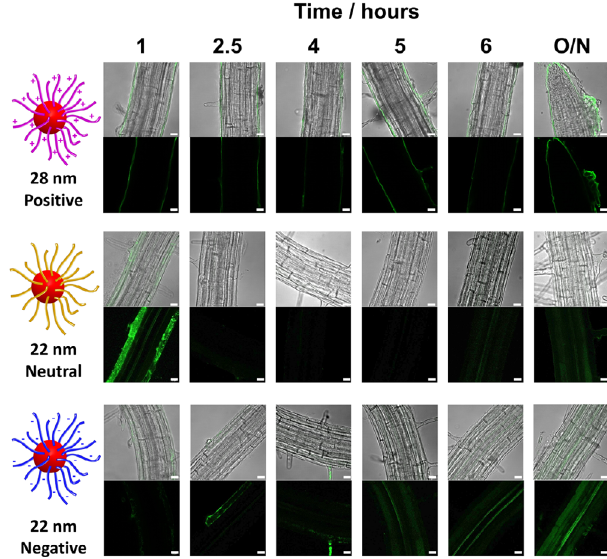
Fig. 5 | Accumulation of nanoparticles over time. Confocal images for the penetration and accumulation of the smallest polymeric nanoparticles in Arabi- dopsis root hair zones over time. Penetration and accumulation were evaluated using a ZEISS 880 LSM. The images are representatives of experimental replicates ( n =3). Maximum Z projections in the 488nm laser channel were analysed along- side the Z-slices and merged with bright fi eld images using ImageJ software. Scale bar=20 μ